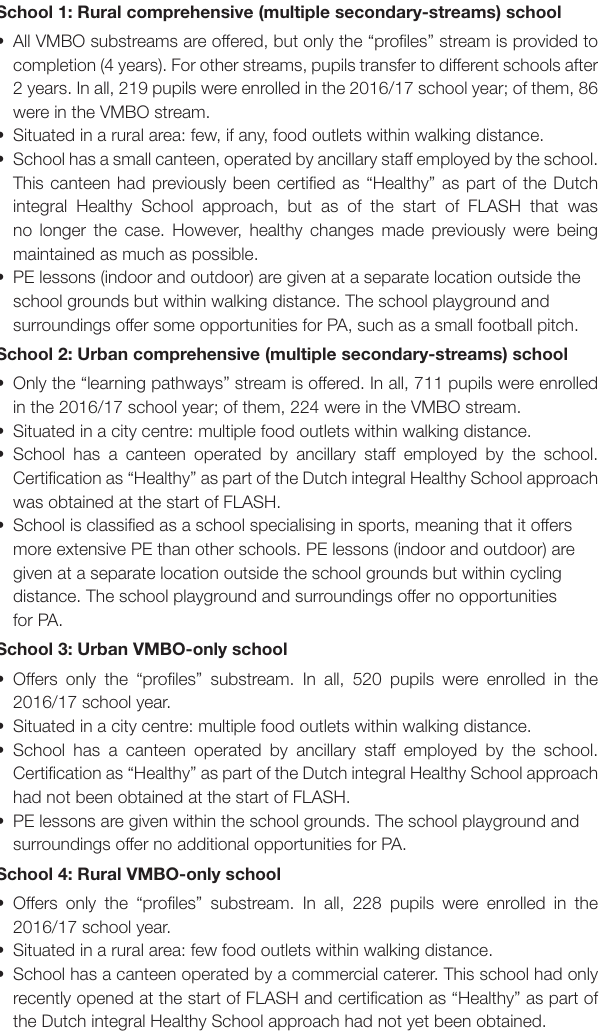
TABLE 1 | Characteristics of FLASH